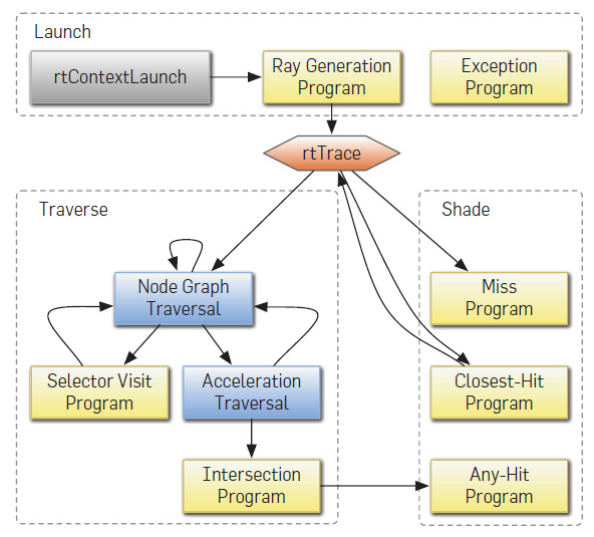
Fig. 1. The NVIDIA OptiX ray tracing